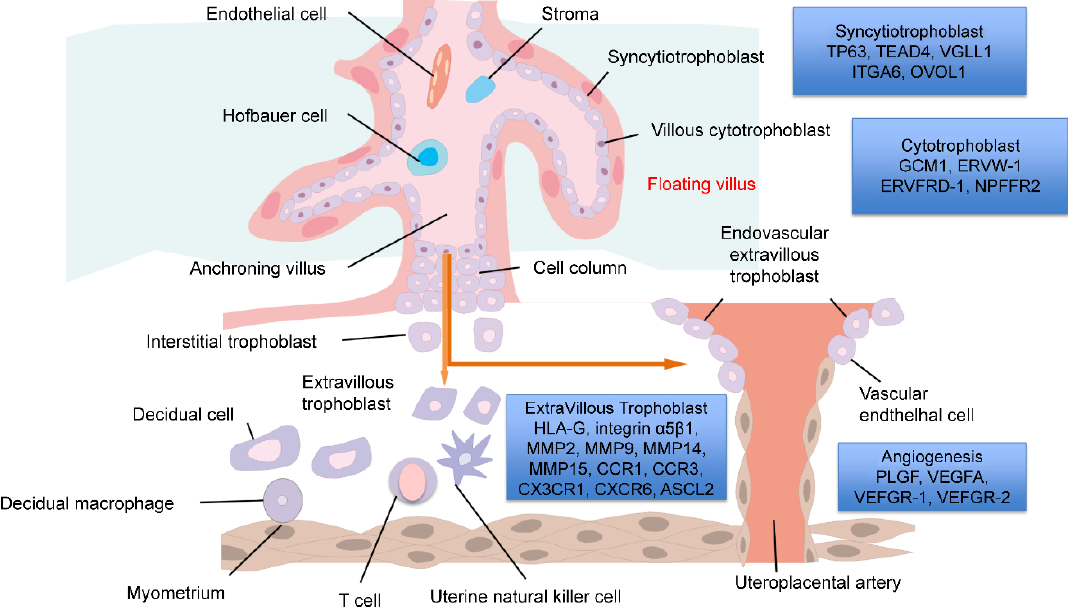
Figure 1. Placental development immediately before implantation and involved genes in the trophectoderm.